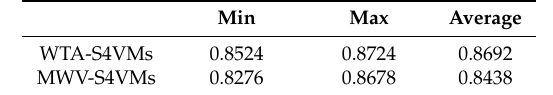
Table 5. Outcome of WTA-S4VMs and MWV-S4VMs in multi-gases.